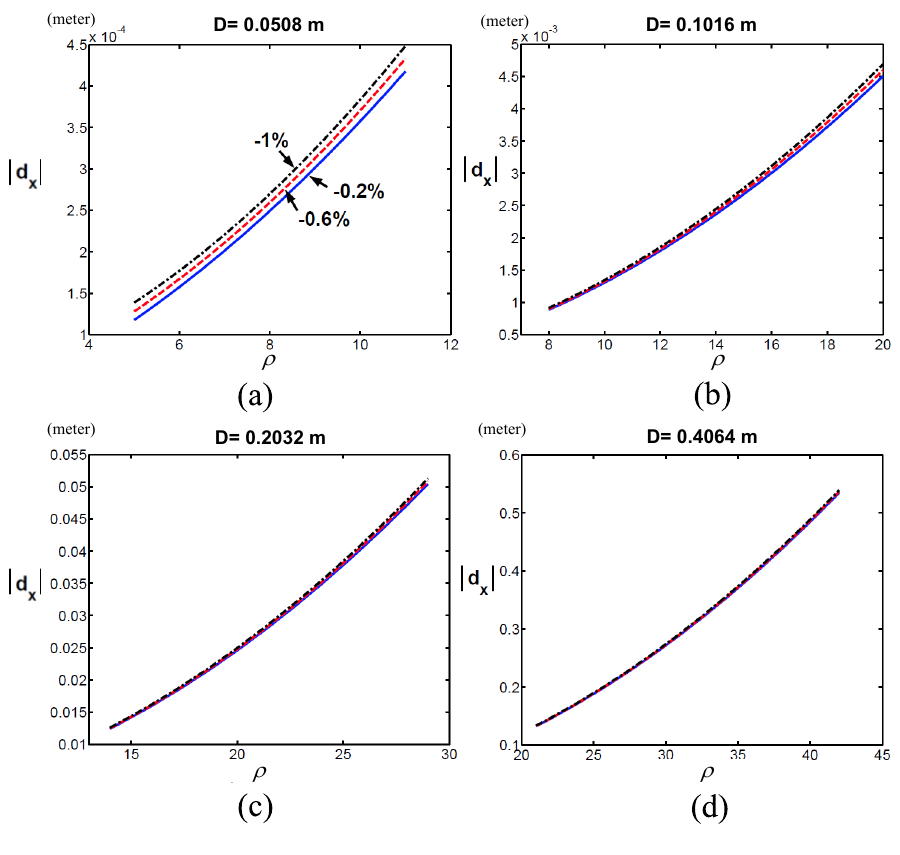
Figure 7. Simulation results of the Cartesian position errors of the end-effector of a PUMA 560 robot along the x -axis ( d ) with respect to the scalar of the joint velocities ( ρ ) when (cid:52) m x was − 1% (black dot-dashed line), − 0 . 6% (red dashed line) and − 0 . 2% (blue solid